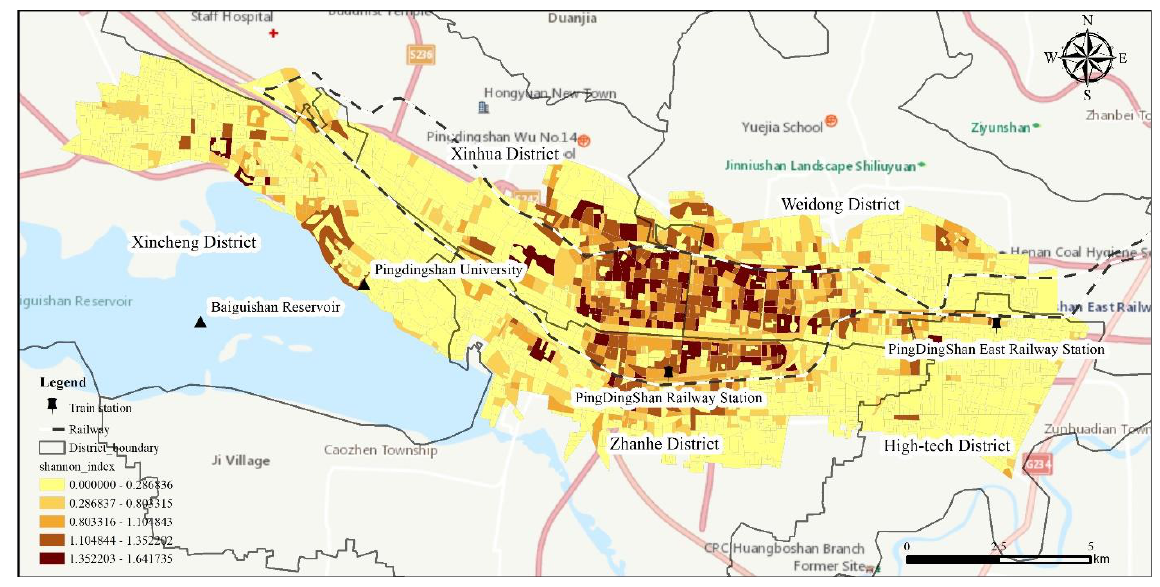
Figure 4. Visualization of the Shannon index based on POI data of road enclosure patches in Ping- dingshan city.